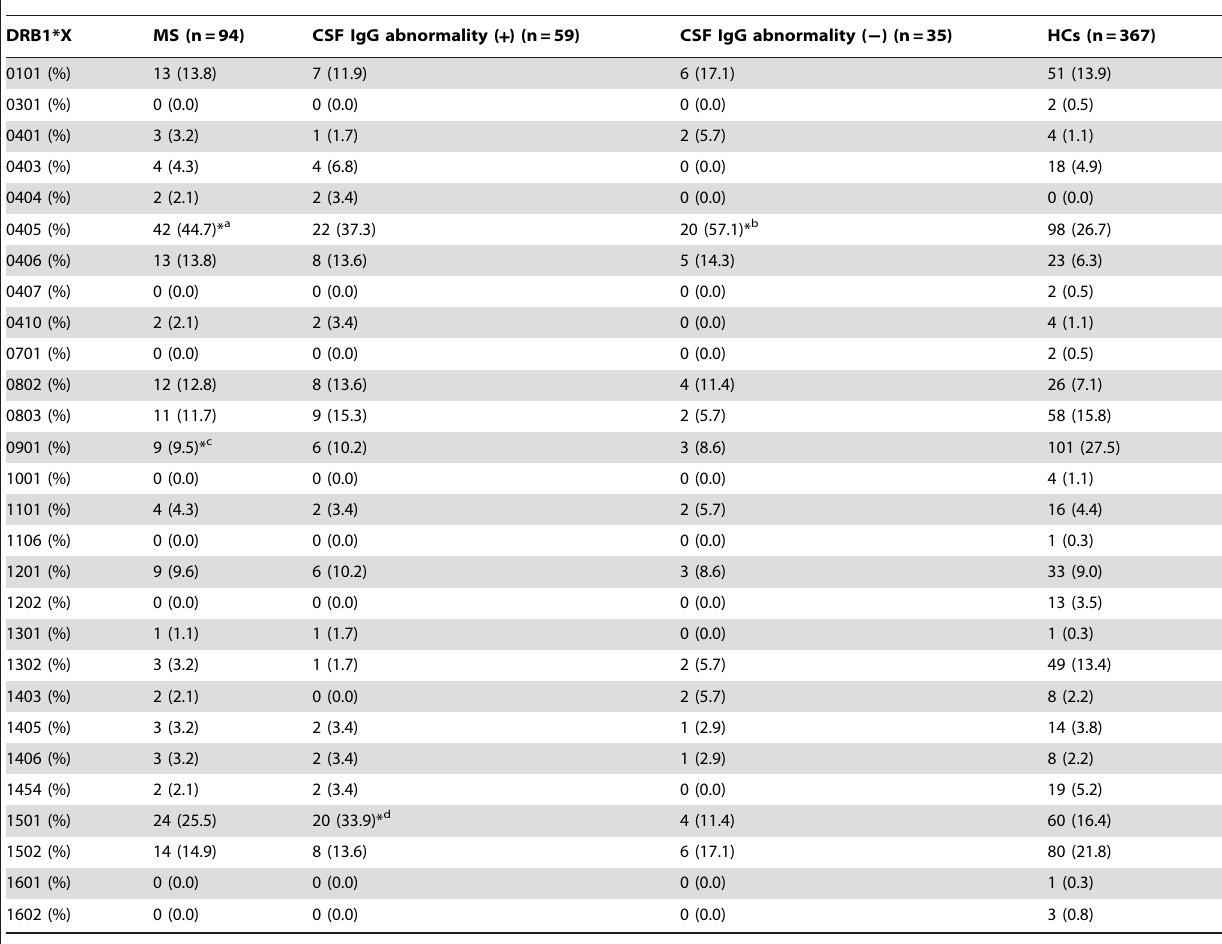
Table 2. Comparisons of the phenotype frequencies of the HLA-DRB1